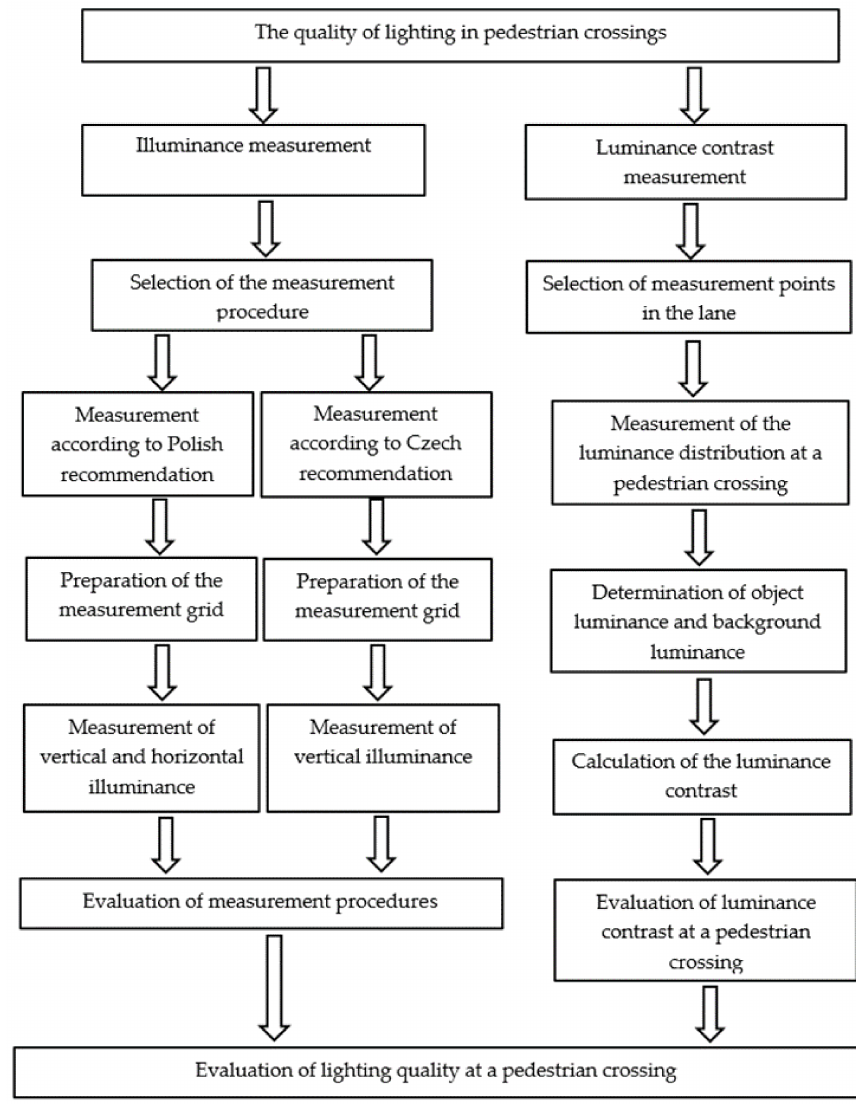
Figure 13. Diagram of the measurement